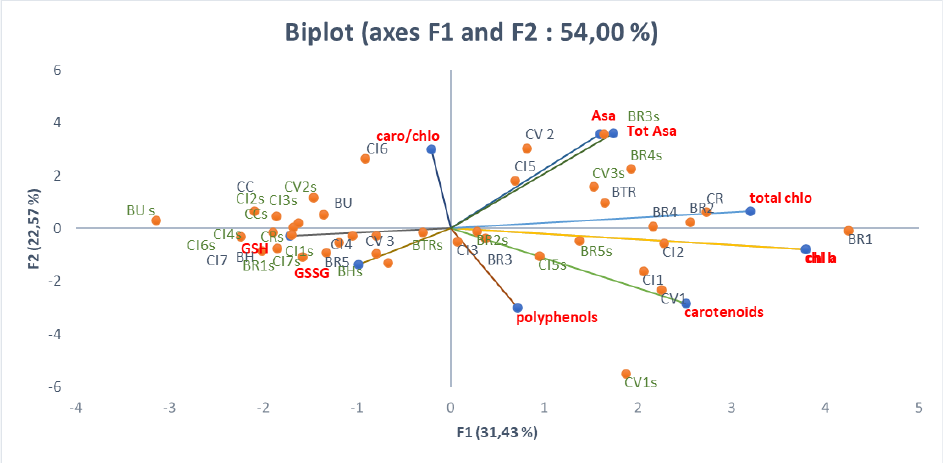
Figure 3. Two-dimensional principal component analysis (2D-PCA) illustrating the biochemical compounds used as biomarkers of water stress. The color green indicates the stressed crops.